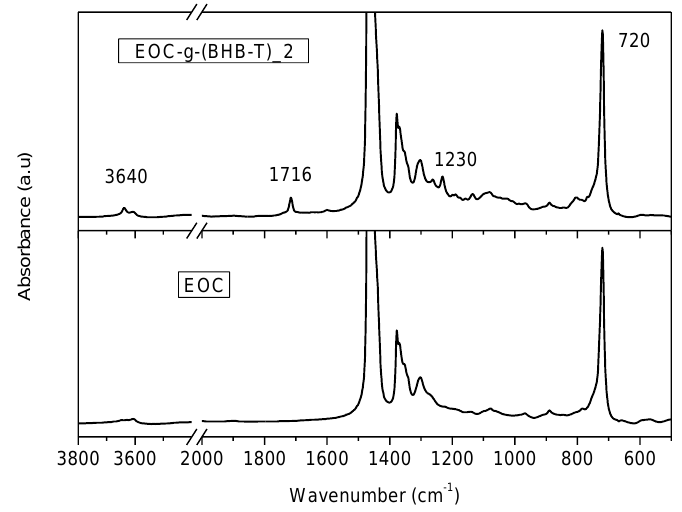
Figure 1. Comparison between the FT-IR spectra of EOC and EOC- g -(BHB-T)_2.